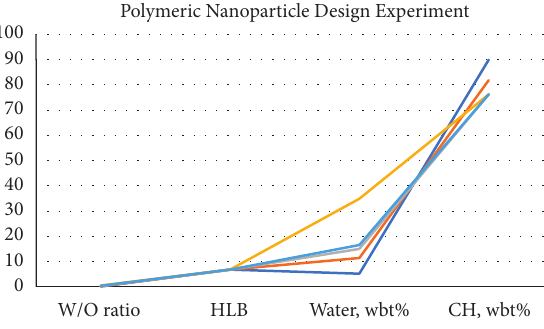
Figure 4: Polymeric nanoparticle design experiment. Table 3: Effect of time and